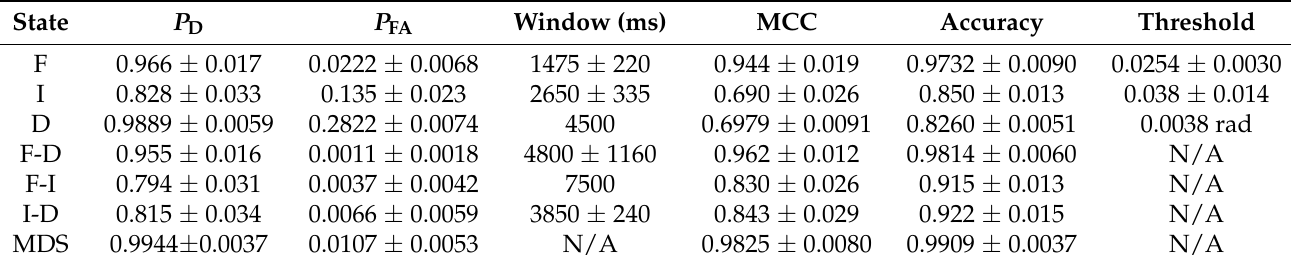
Figure 5. Features fusion analysis. Table 3. States detection prediction results.